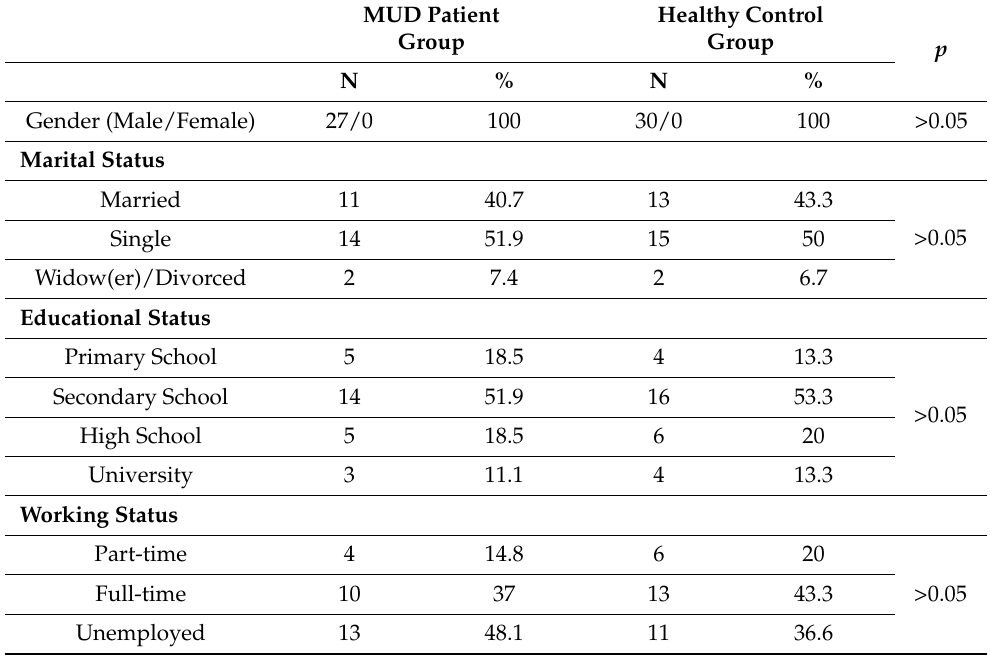
Table 1. The demographic characteristics of the patient and control groups.